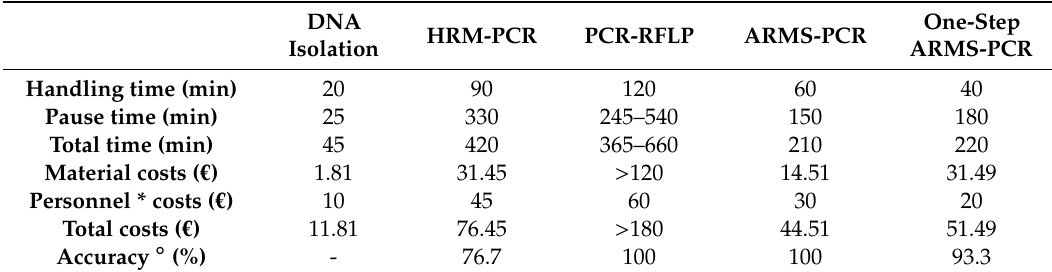
Table 4. Time and cost to analyze 10 samples (three SNPs in duplicates + controls) with the di ff erent SNP detection methods, including method